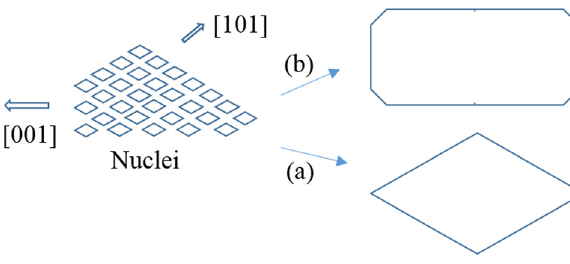
Figure 8: Scheme diagram of di ff erent morphology formation ( a ) without surfactant and ( b ) with CH 3 ( CH 2 ) 5 NH 2